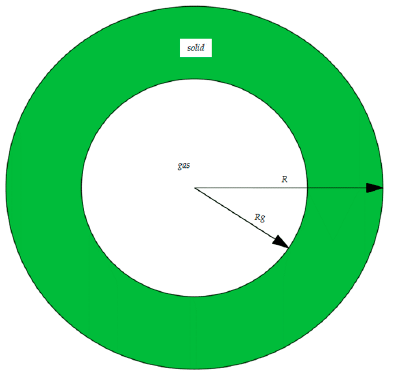
Figure 6. Swirl flow model diagram of gas-solid two-phase pipeline.